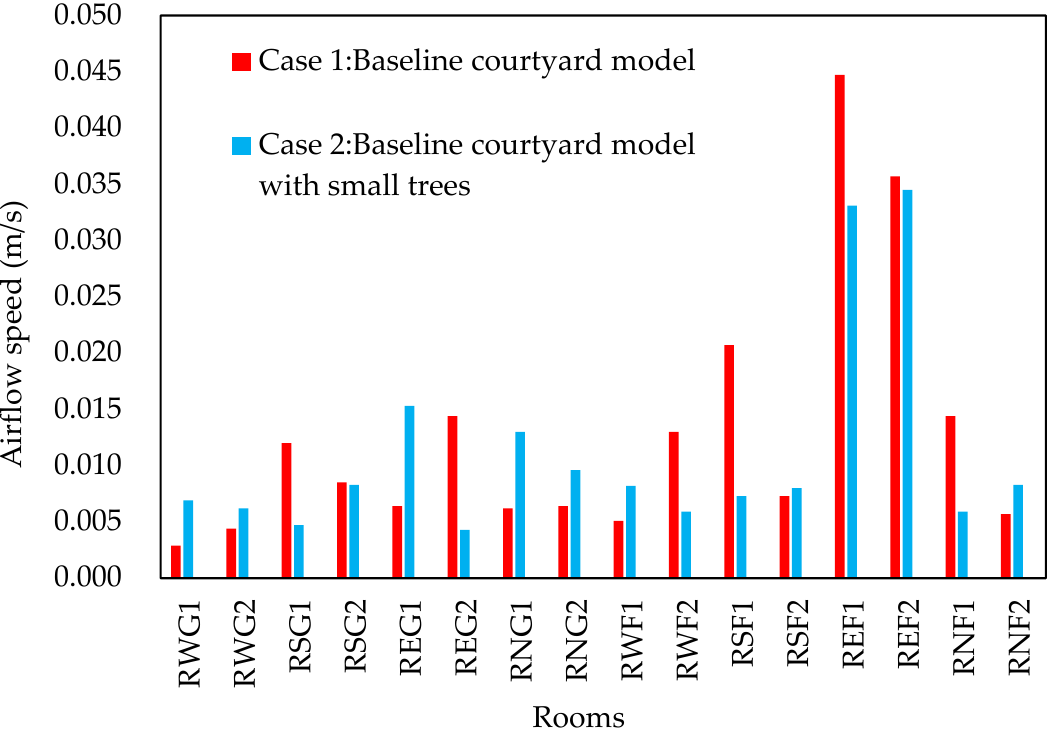
Figure 22. Comparison of wind speed magnitude for Case 1 and Case 2 in each room.